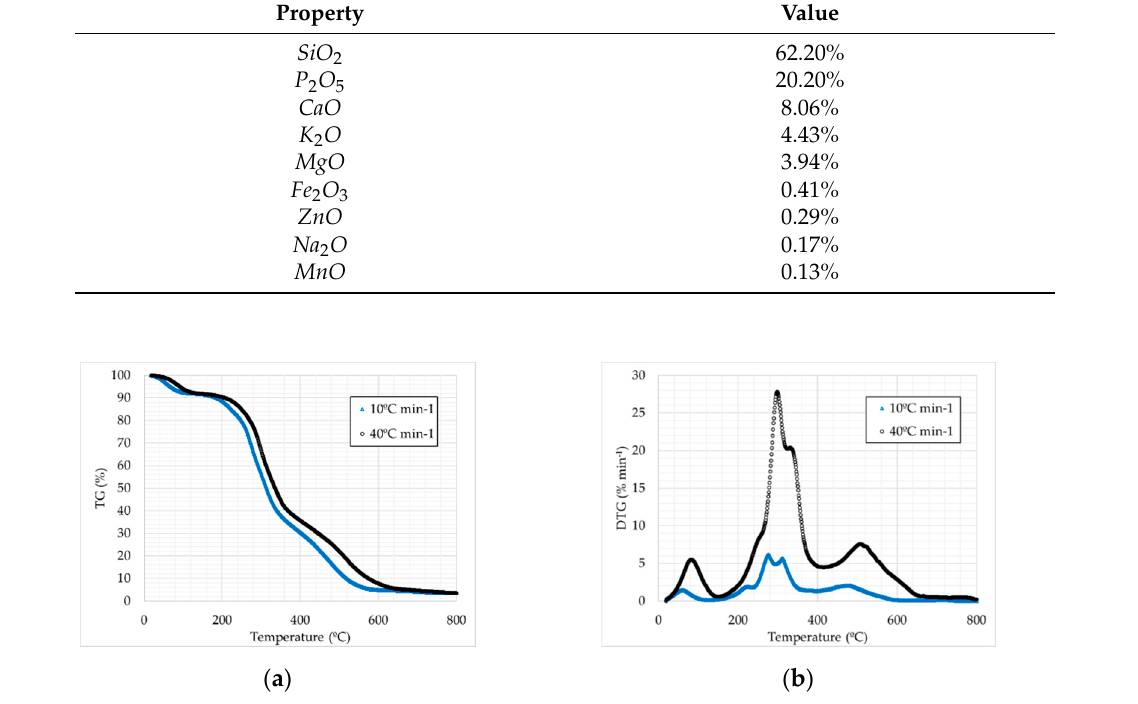
Figure 6. TG ( a ) and DTG ( b ) curves for heating rates studied under oxidative atmosphere.